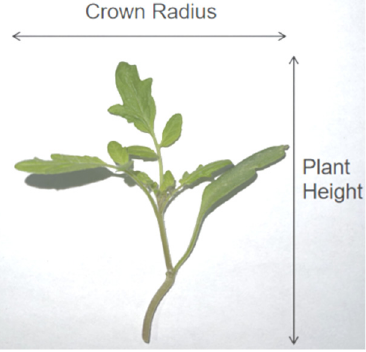
Figure 1. Tomato seedlings for separation.